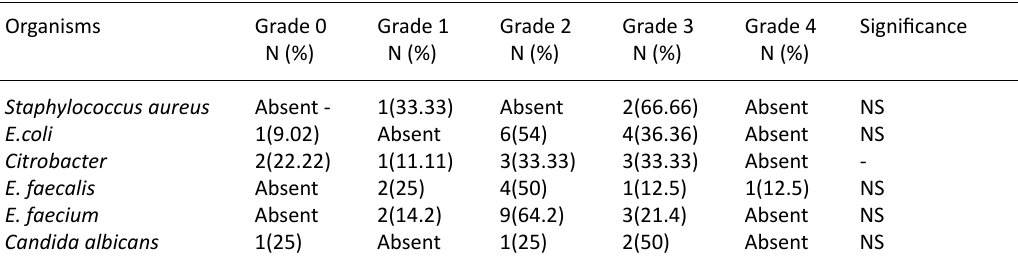
Table 5. Bacterial and yeast flora present with Mucositis grading